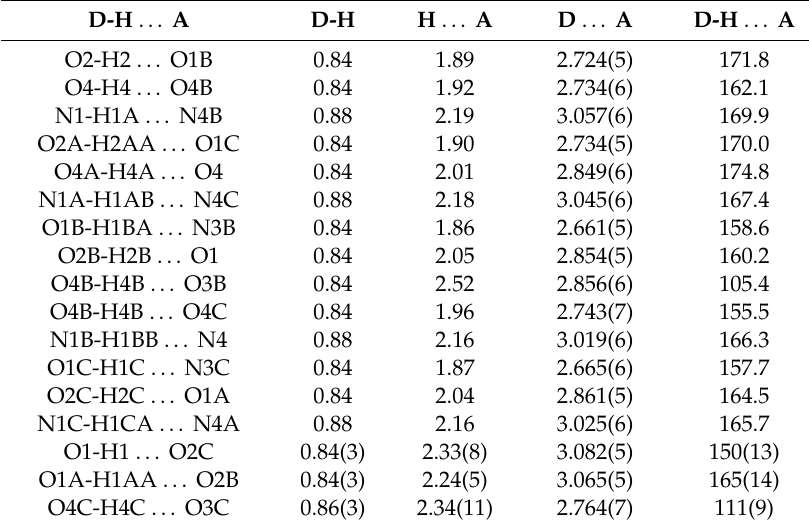
Figure 6. ( a ) Face indexation for TICA form Ⅱ and ( b ) Morphology predictions for TICA form Ⅱ by means of BFDH calculations.